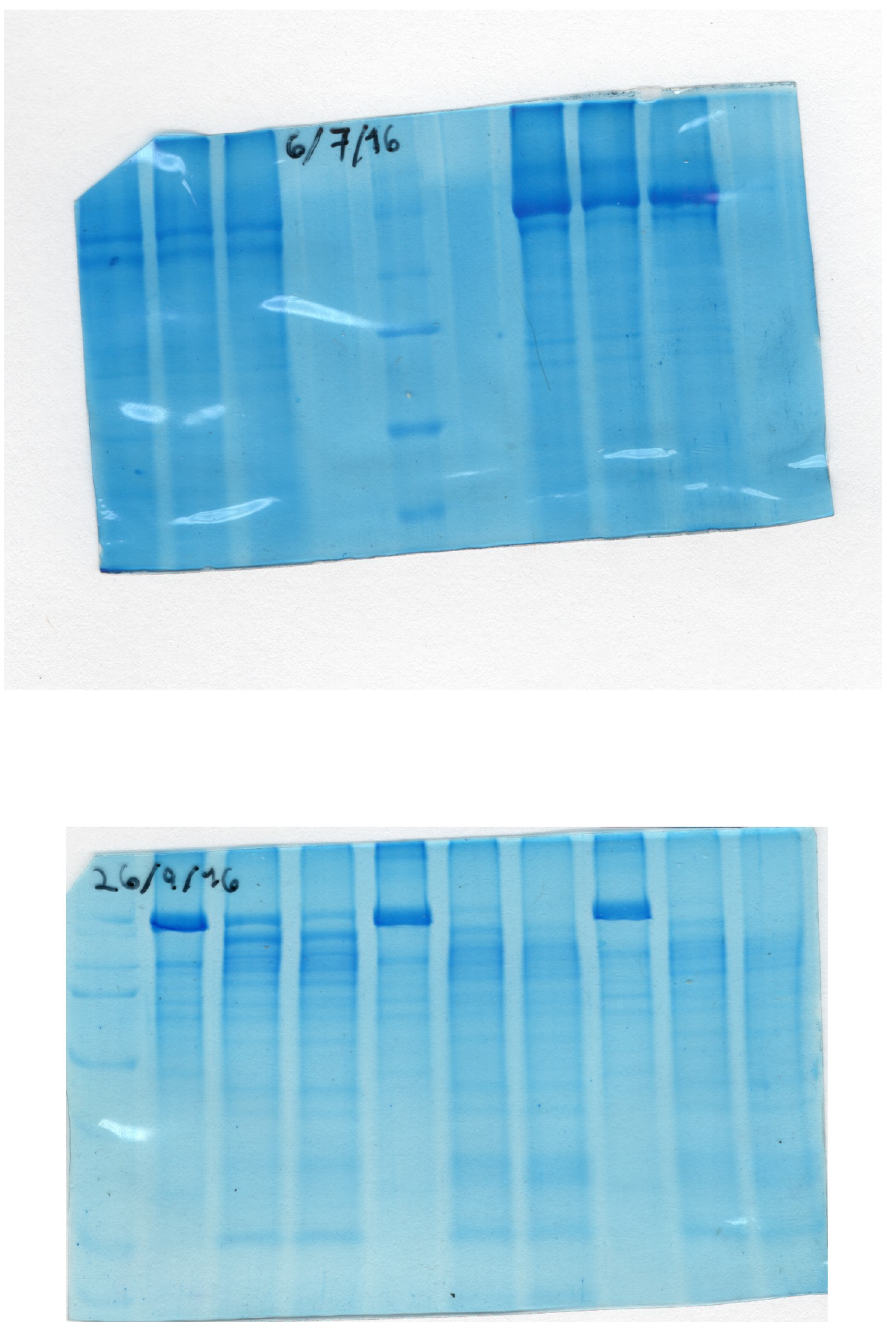
Fig 5. Effect of ATP on chymotryptic digestion of GFP-Spf1p. 3 μ g of GFP-Spf1p was exposed to chymotrypsin (ratio w/w, 30:1) and the reaction was stopped by the addition of TCA. The composition of the proteolytic medium was EDTA , 2 mM EDTA, Mg , MgCl 2 enough to give 2 mM free Mg 2+ , and Ca , CaCl 2 enough to give 100 μ M free Ca 2+ , each condition with or without 3 mM ATP. Top panel , the protein was digested for 30 min. Bottom panel , the proteolysis media were the same as described above and the numbers proteolysis time is indicated on top of each lane.